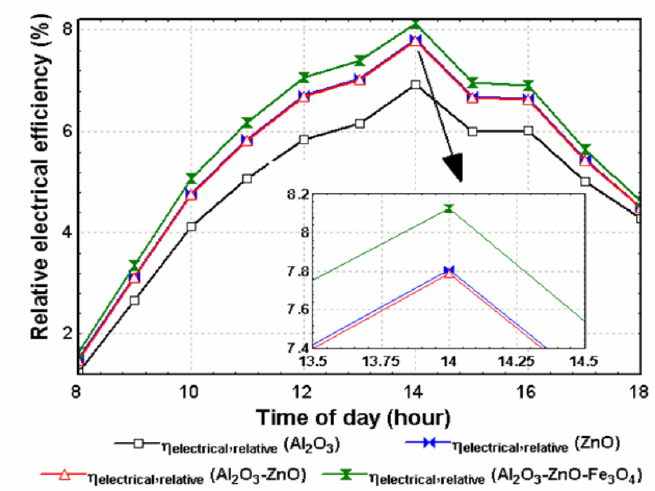
Figure 14. Relative electrical efficiency of PV/T